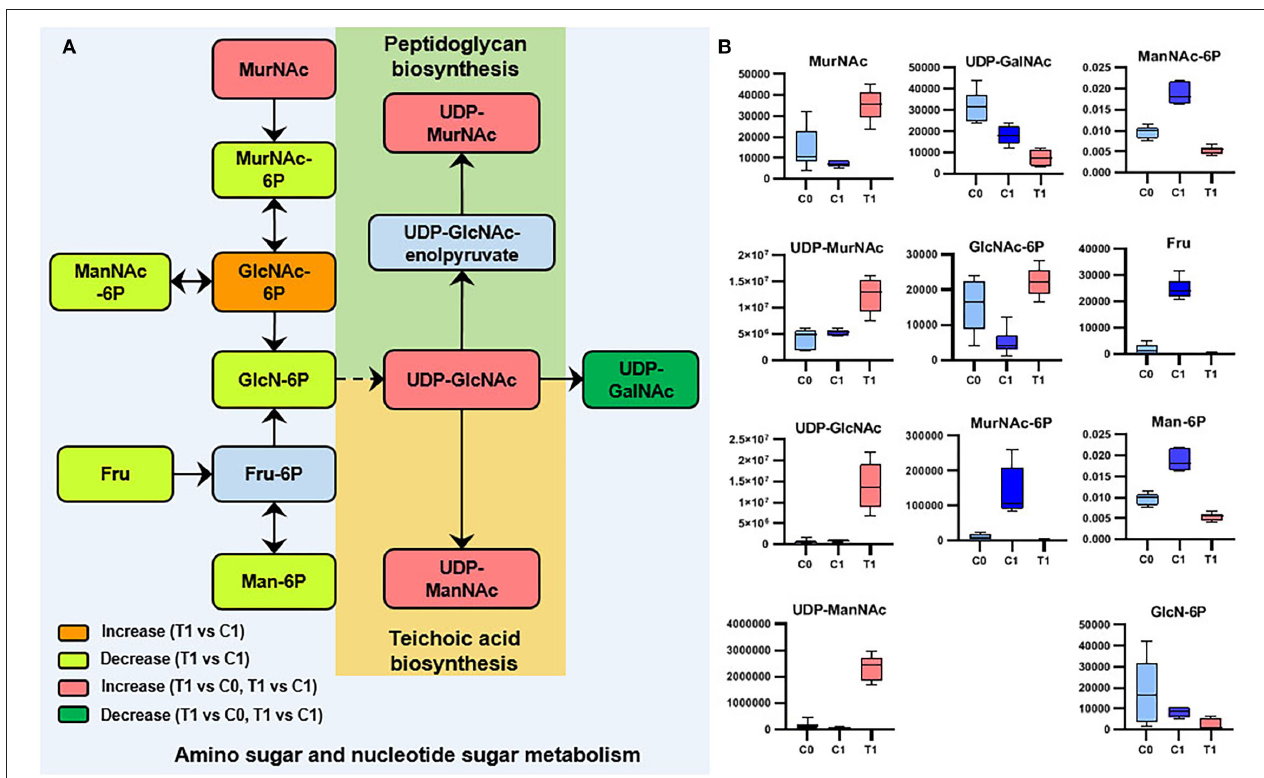
FIGURE 3 | Significant metabolites involved in amino-sugar and sugar-nucleotide metabolism. (A) Relationship among metabolites. T1: BBR-exposed group; C0: initial control group; C1: growth control group. (B) Box plots for metabolites marked in A (|log 2 FC| > 1; P < 0.05; adj. P -value <